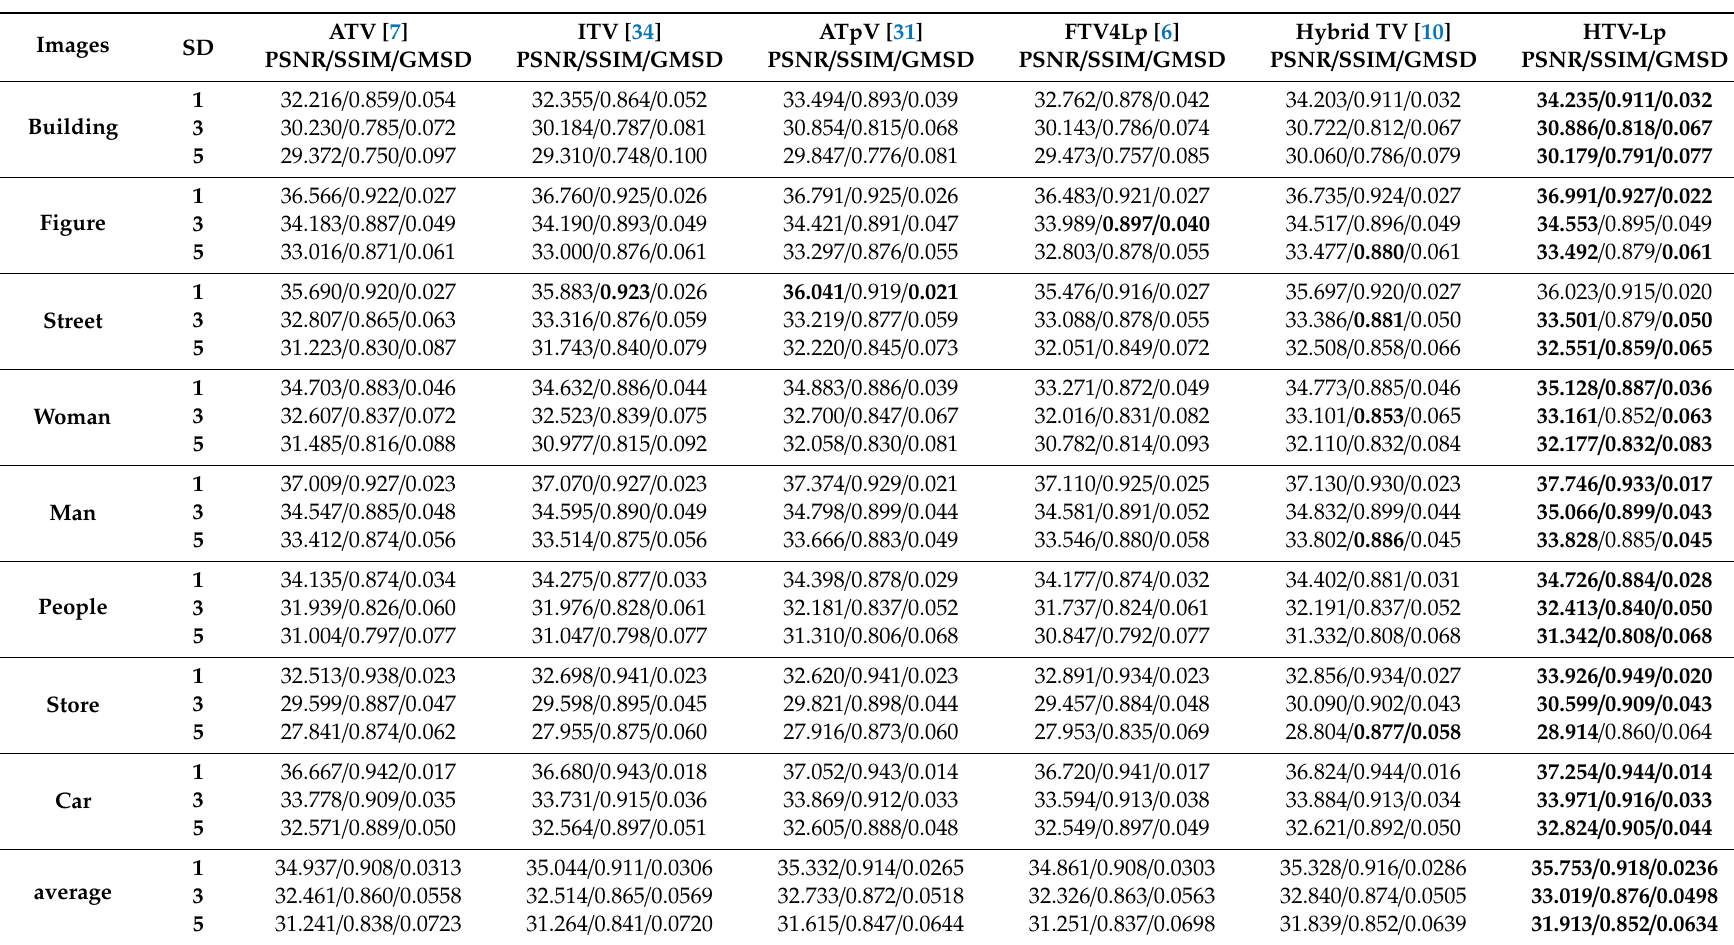
Table 2. Evaluation metrics of the six algorithms for various images with motion blur (M, 10, 10) with a Gaussian noise standard deviation (SD) of 1, 3, and 5.